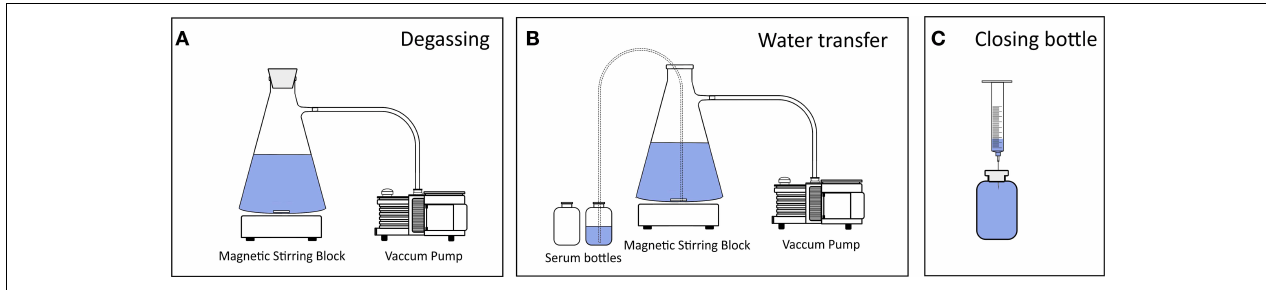
FIGURE 1 | Set-up of low-pressure degassing and bottling of water. (A) Water was filled into a filtration flask, which was closed air-tight, placed on a magnetic stirring block and connected to a vacuum pump. During degassing the stirring was set to its maximum (1400rpm) causing a turbulent vortex. (B) Water was transferred into borosilicate serum bottles via siphoning through gas-tight tubing so that atmospheric pressure forced the water to flow from the filtration